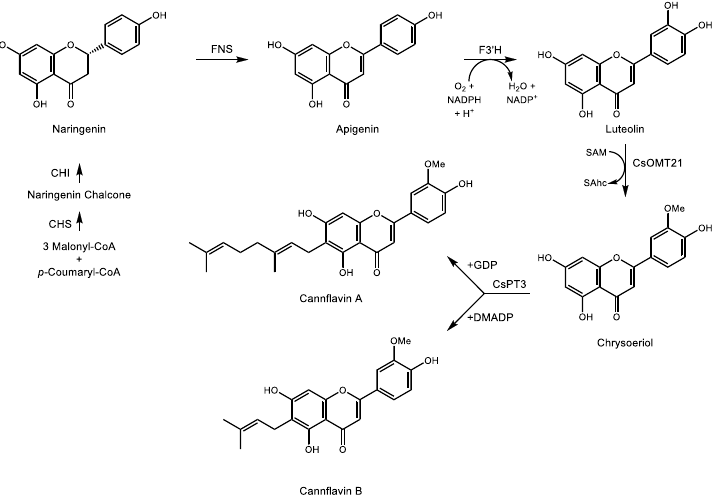
Figure 5. Biosynthetic pathway for the formation of cannflavin A and B in C. sativa and C. indica .